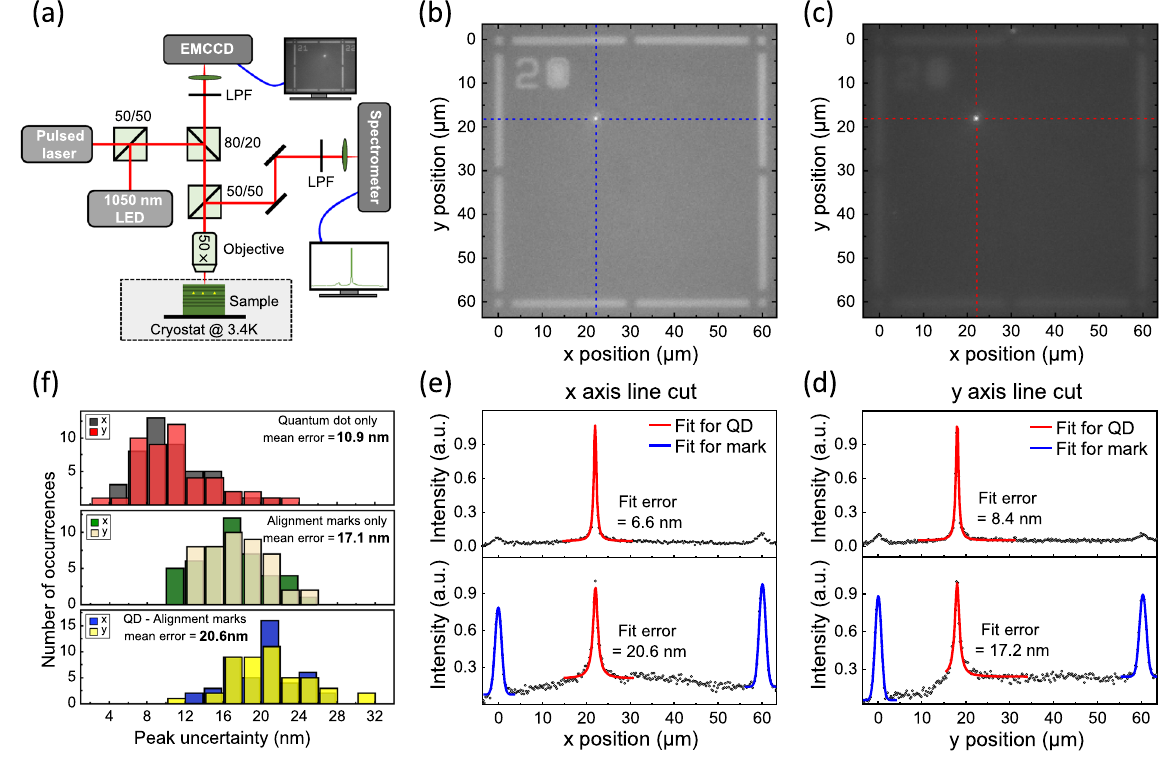
Figure 1. ( a ) Schematic of the micro-photoluminescence measurement and two-color photoluminescence imaging setup. ( b – e ) Method to acquire the relative position of the QD: ( b ) EMCCD image of the alignment marks when focusing on the surface. ( c ) EMCCD image of the photoluminescence from a single QD when focusing on the QD layer that is at the center of λ -GaAs cavity ( ≈ 1.85 μ m below the surface). ( d , e ) x ( y ) axis line cut along the horizontal(vertical) dot line in ( b ) and ( c ), showing the QD emission, light intensity reflected by metallic marks. Herein, the Lorenz fit (red lines) and Gaussian fits (blue lines) are used to determine the location of the QD and the center position of alignment mark, respectively. The positions are then translated from a pixel value on the images to a distance on the sample by counting the number of pixels between two nearby marks with known distance. ( f ) Histograms of the uncertainties of the QD and alignment mark positions and QD-alignment mark separations (47 images). The uncertainties represent one standard deviation values determined by a nonlinear least squares fit of the